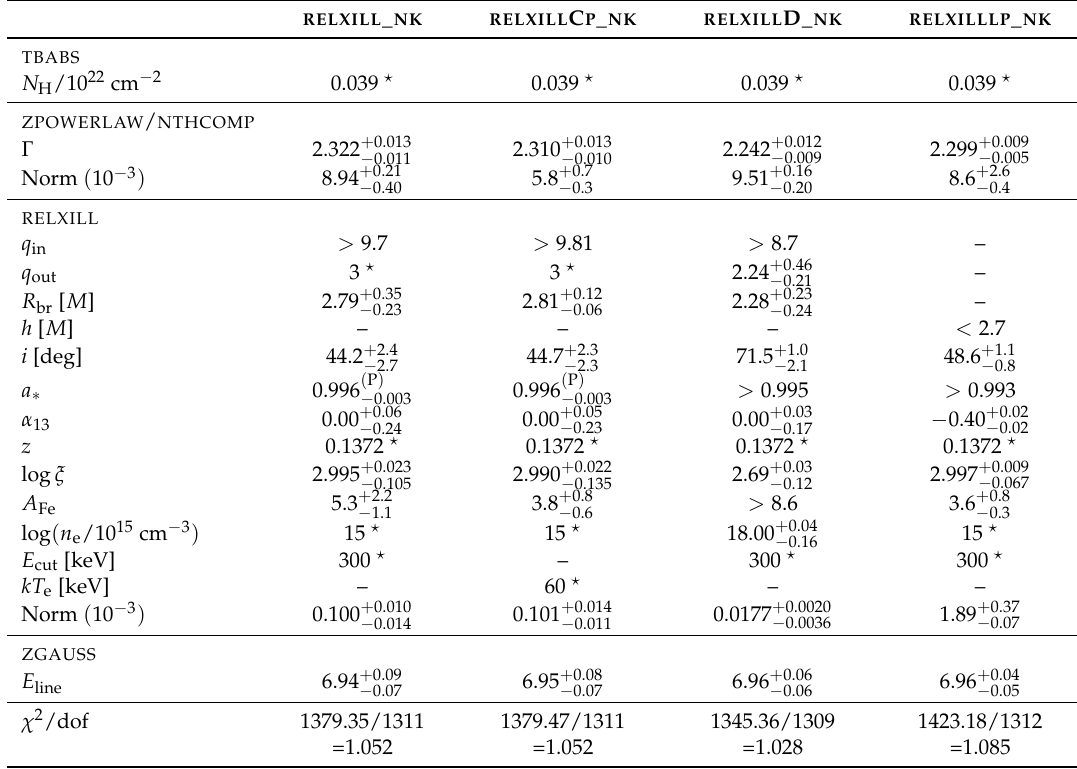
Table A5. Summary of the best-fit values for the supermassive black hole in PKS 0558–504. (cid:63) indicates that the parameter is frozen to that value in the